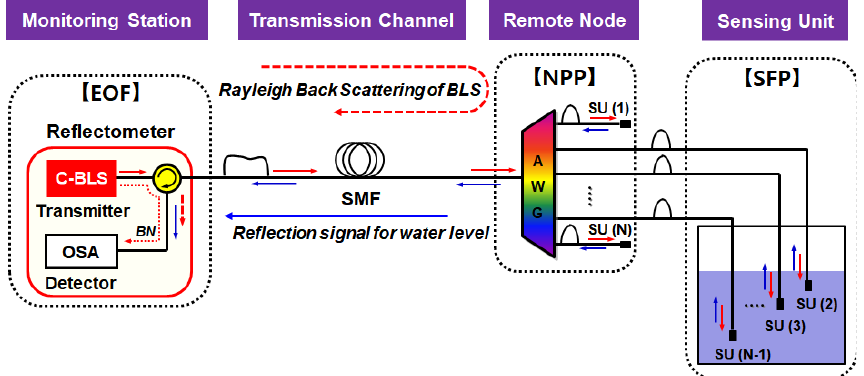
Figure 1. Configuration of the dense wavelength division multiplexing (DWDM)-passive optical fiber sensor network.